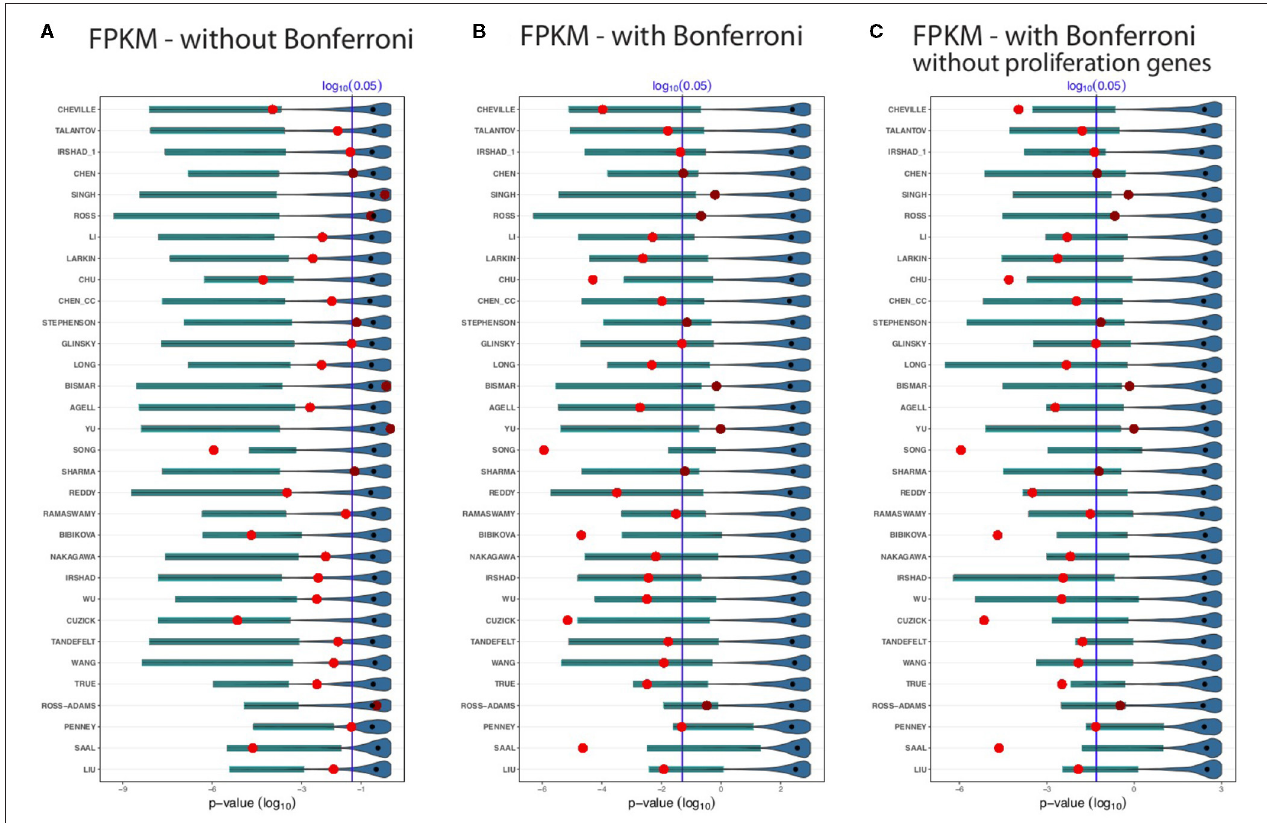
FIGURE 3 | Shown are the prognostic prediction results of random gene sets for 32 signatures using the GDC cohort A data. (A) Results for uncorrected p -values. (B) Bonferroni corrected p -values. (C) Proliferation genes are removed and the p -values are Bonferroni corrected. The significance level is α = 0.05 (vertical blue line) and the light/dark red points represent the outcome of the published signatures. The blue-colored distributions are the results of the random gene sets, whereas the shaded cyan bars correspond to the lower third percentile of the distributions and the bold black points are the median